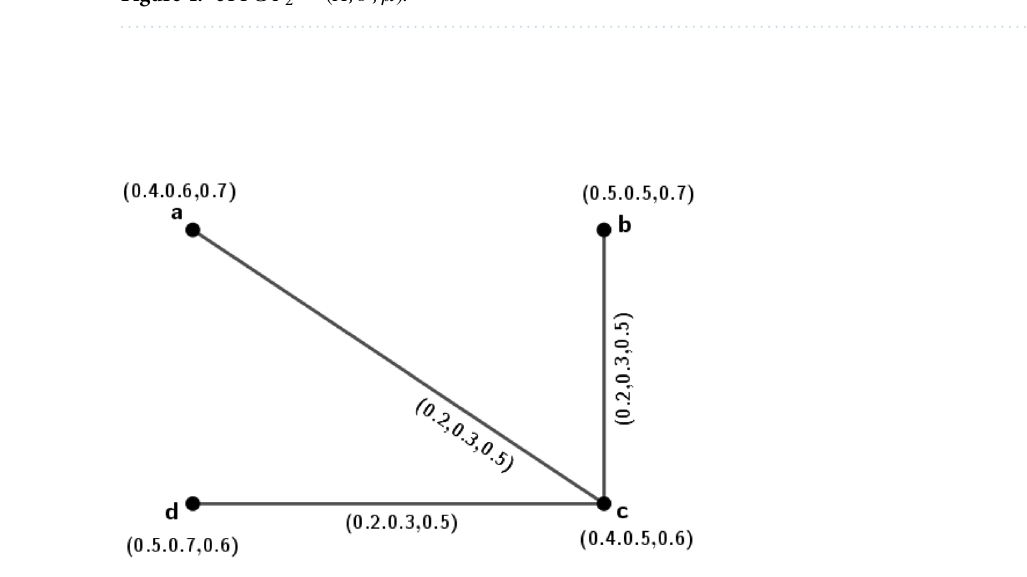
Figure 4. 3PFG Γ 2 = (